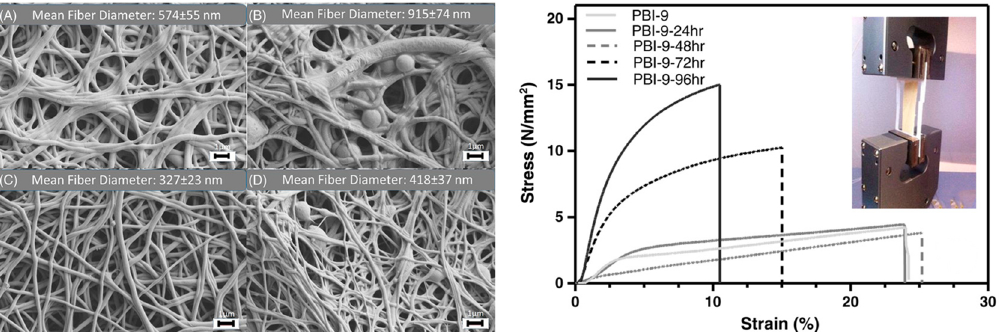
Figure 25. ( Left ) Scanning electron microscope micrographs of ( A ) PBI-9–24 h, ( B ) PBI-9–48 h, ( C ) PBI-9–72 h, and ( D ) PBI-9–96 h phosphoric acid–doped polybenzimidazole (PBI) nanofibers and ( right ) stress–strain curves of undoped and PA doped during 24, 48, 72, and 96 h electrospun membranes. Reproduced from [240] with permission of John Wiley and Sons.